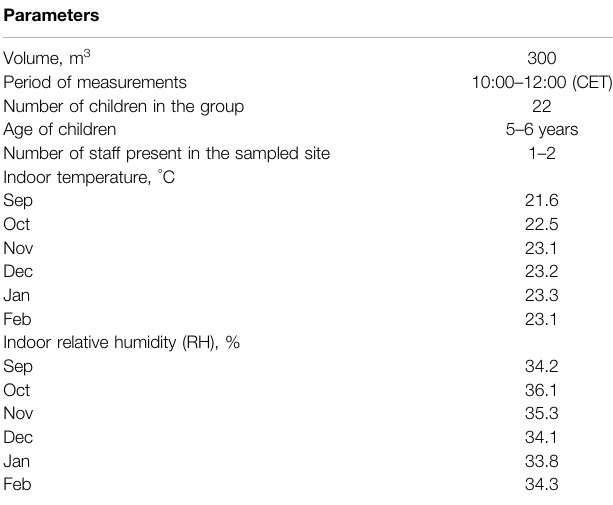
TABLE 1 | The main characteristics of the studied nursery school in Gliwice, Poland.